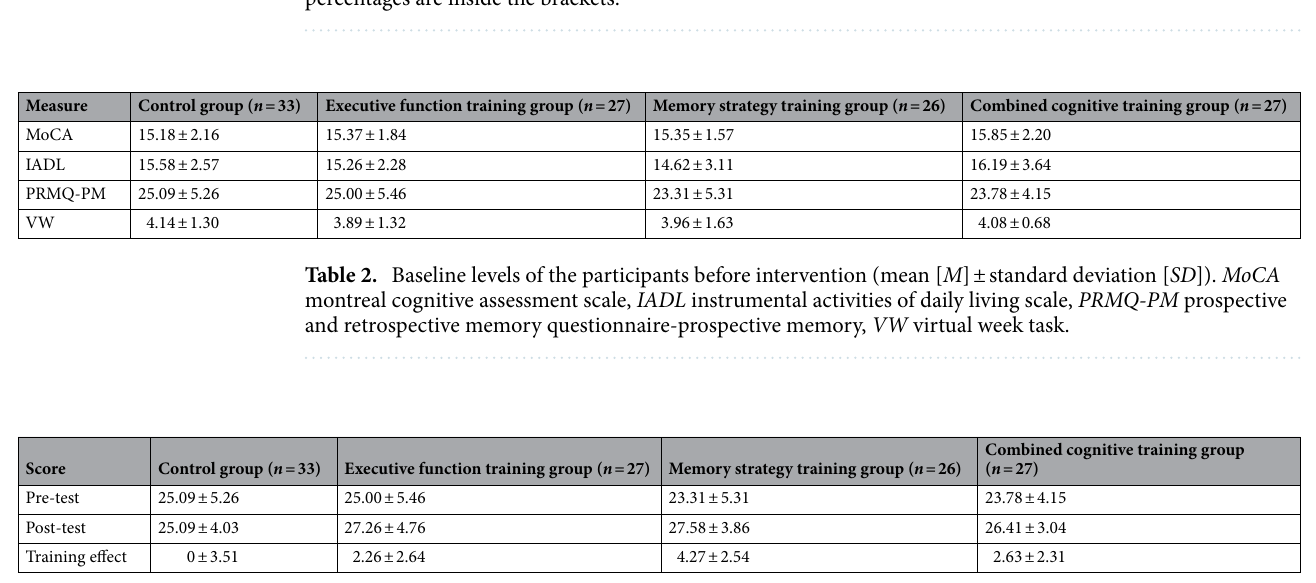
Table 1. Characteristics of the control group and intervention groups. Numbers are outside the brackets, percentages are inside the brackets.